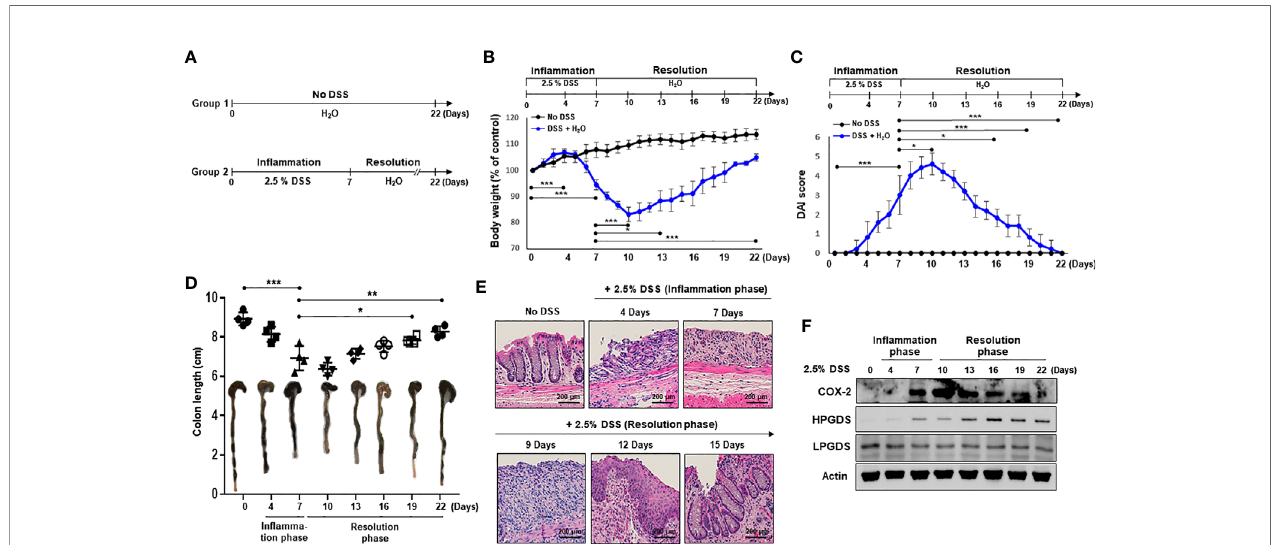
FIGURE 1 | HPGDS responsible for the synthesis of 15d-PGJ 2 is transiently upregulated during spontaneous resolution of dextran sulfate sodium (DSS)-induced colitis. (A) Mice were administrated with drinking water containing 2.5% DSS for 7 days, followed by normal water for 15 days. “ No DSS ” indicates mice without DSS administration. (B) Gradual change of body weight. (C) Disease activity index (DAI) based on the severity of stool consistency and rectal bleeding was measured every day during the experiment period. (D) The comparison of the colon length at the in fl ammation phase and resolution phase of intestinal in fl ammation. (E) Representative distal colon sections stained with hematoxylin and eosin (H&E). (F) COX-2, HPGDS, and LPGDS levels in colon tissue of the in fl ammation phase and resolution phase of in fl ammation were determined by immunocytochemical analysis. All data represent mean ± S.D. (n = 4). * p < 0.05, ** p < 0.01, and *** p <